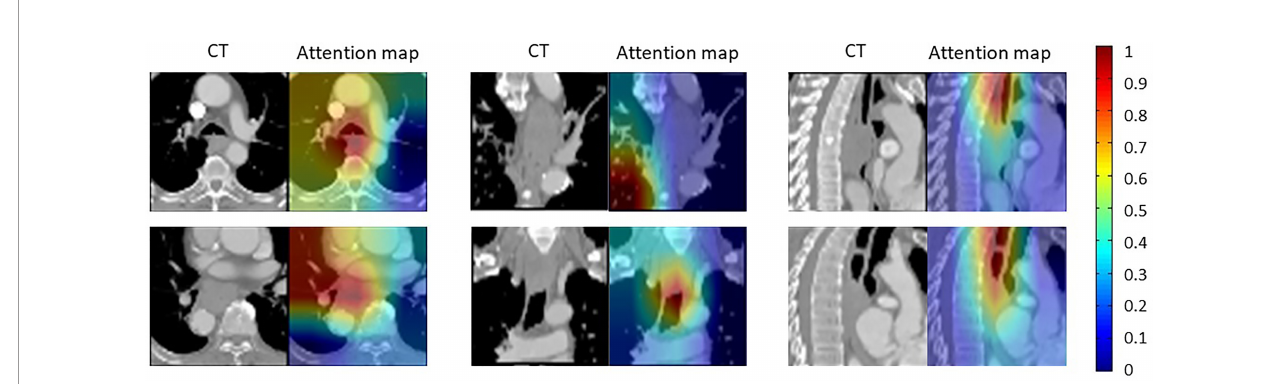
FIGURE 4 | Visualization of attention maps of six patient examples. The attention heatmap shows the risk model ’ s focus on esophageal fi stula prediction. The hotter areas indicate that the tissues have greater impact on esophageal fi stula formation. As shown, the tumor boundaries and the hypoechoic area inside the tumor are